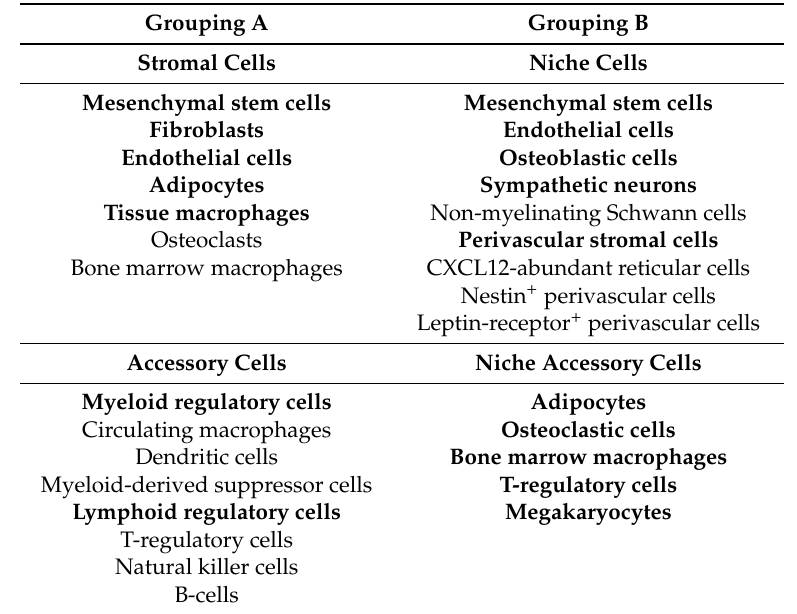
Table 1. Cellular components of the BM microenvironment